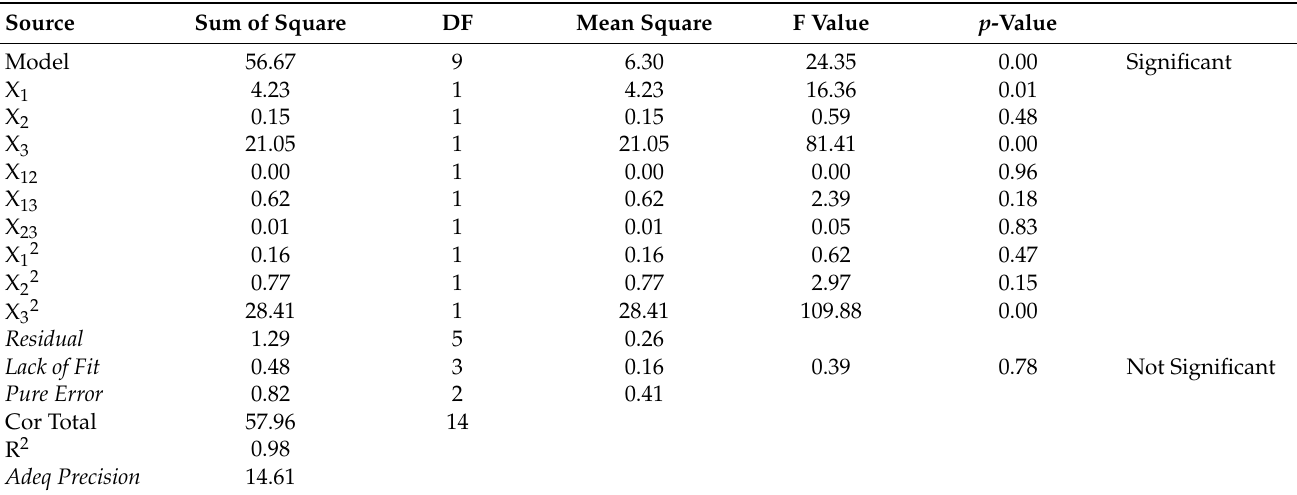
Table 7. Analysis of the Variance and Regression Coefficients of the BBD Quadratic Model to Predict the FFA